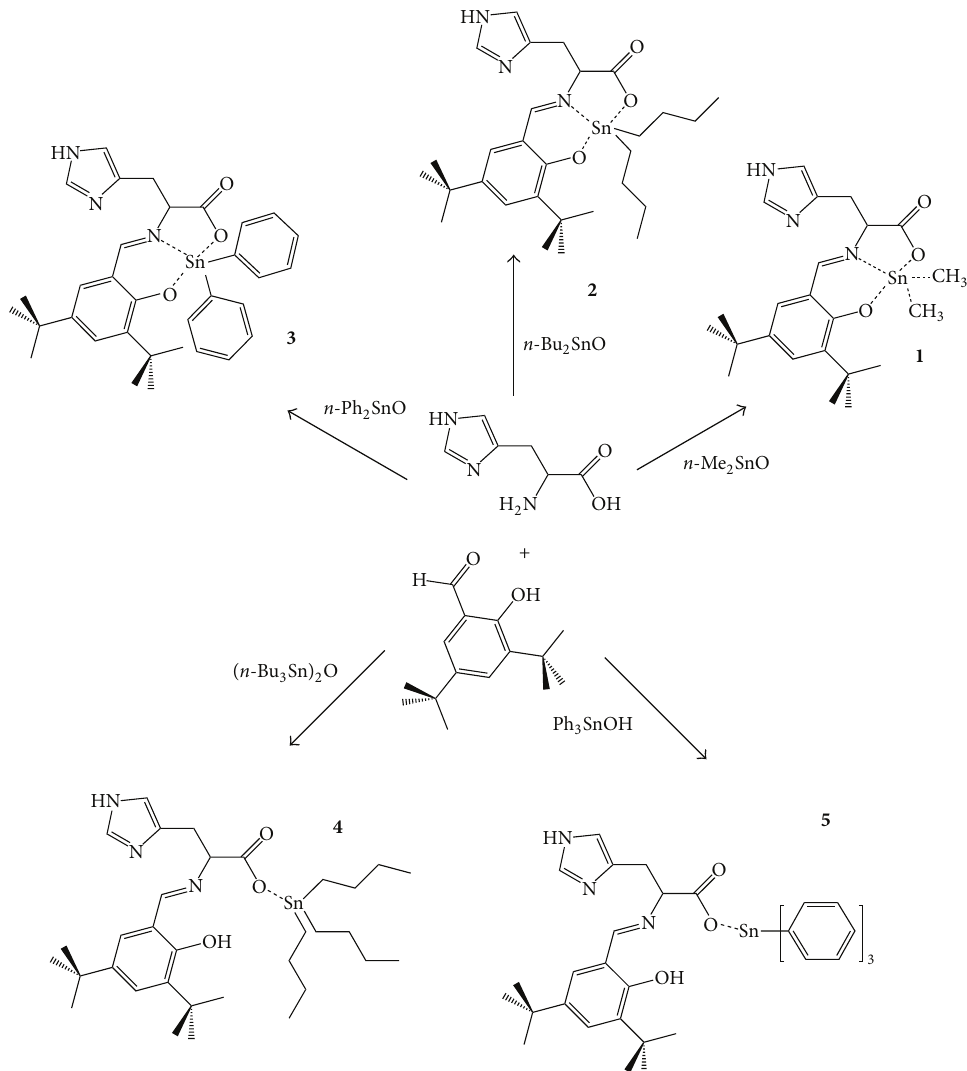
Figure 1: Schematic representation of compounds 1 – 5 and their synthetic